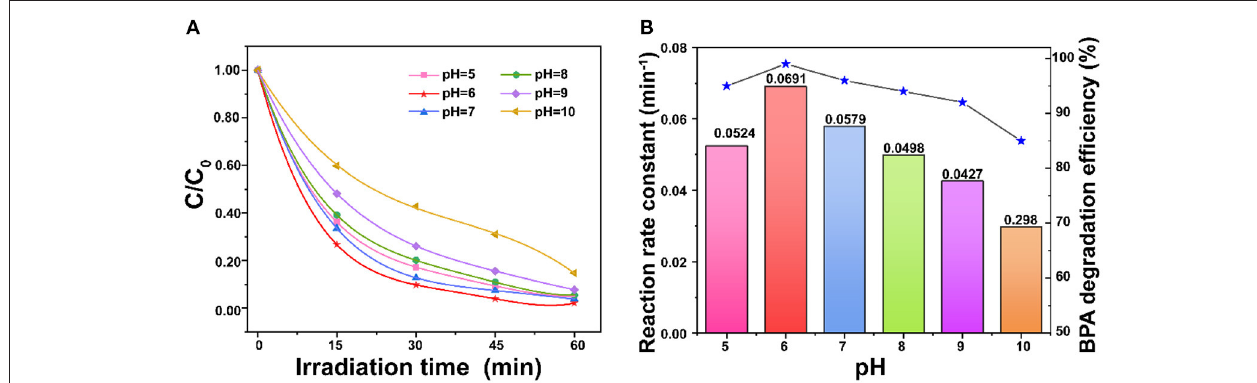
FIGURE 6 | (A) Comparison of pH on degradation of BPA; (B) Effect of pH on the reaction rate constant over porous ZnO under simulated sunlight irradiation (BPA concentration = 30 mg/L and ZnO dosage = 1